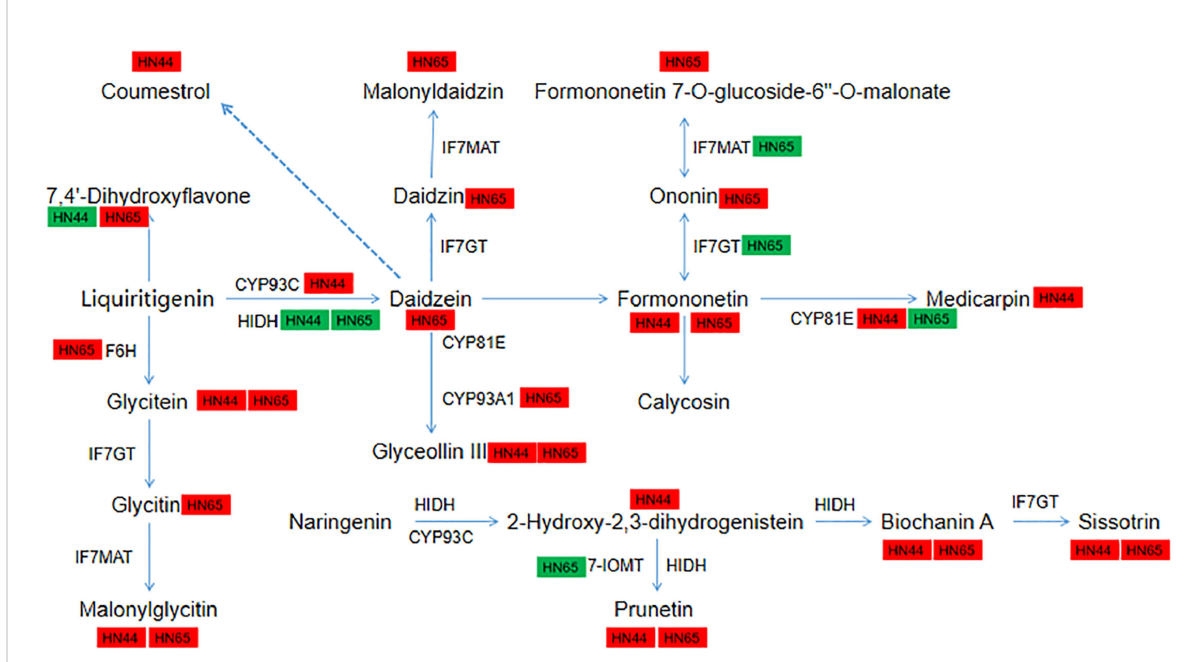
FIGURE 11 Pathway diagram of iso fl avone synthesis. In this fi gure, red indicates up- regulation of genes/metabolites, and green indicates down-regulation of